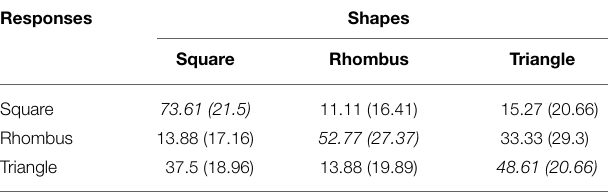
TABLE 3 | Response matrix for Experiment